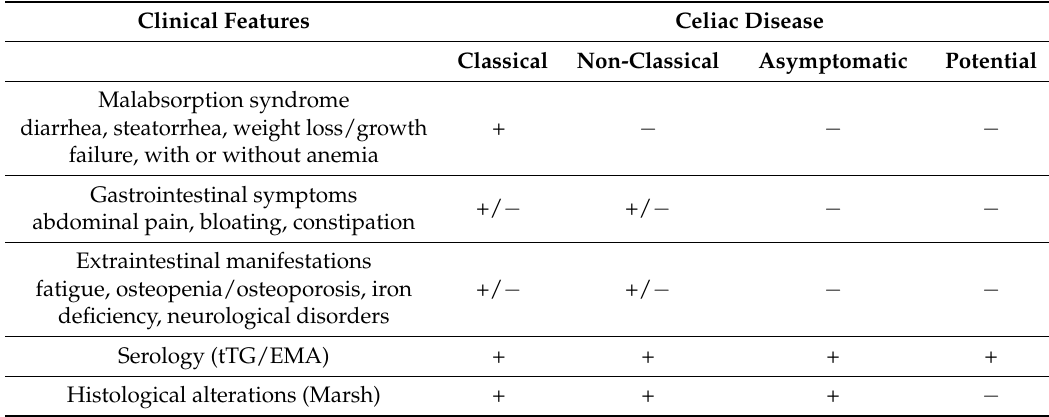
Table 1. The spectrum of clinical presentations of celiac